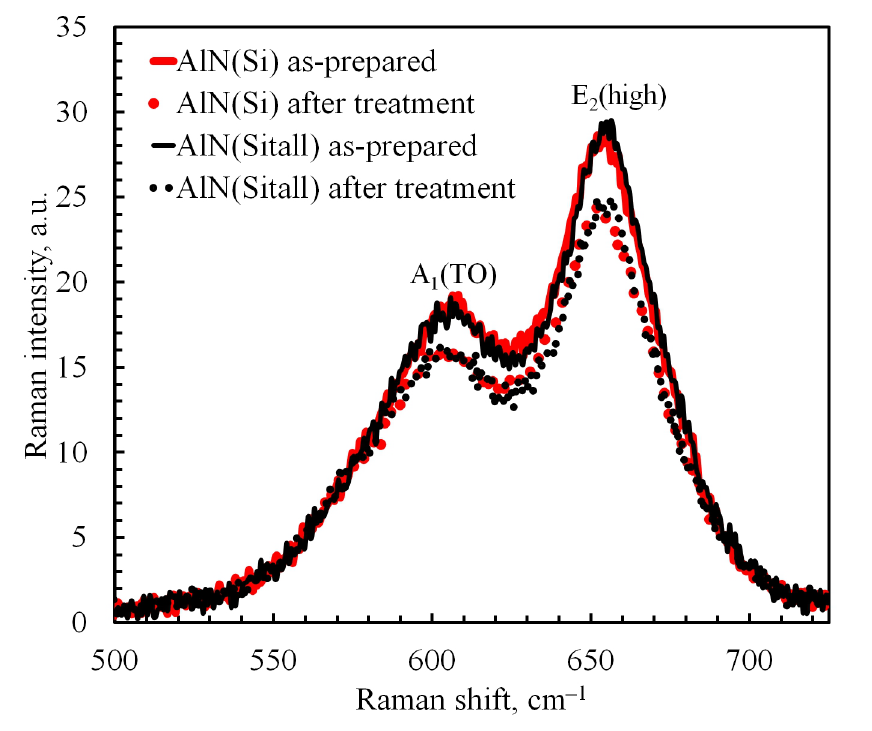
Figure 5. Raman spectra of AlN before (solid) and after (dot) treatment with cluster ions.